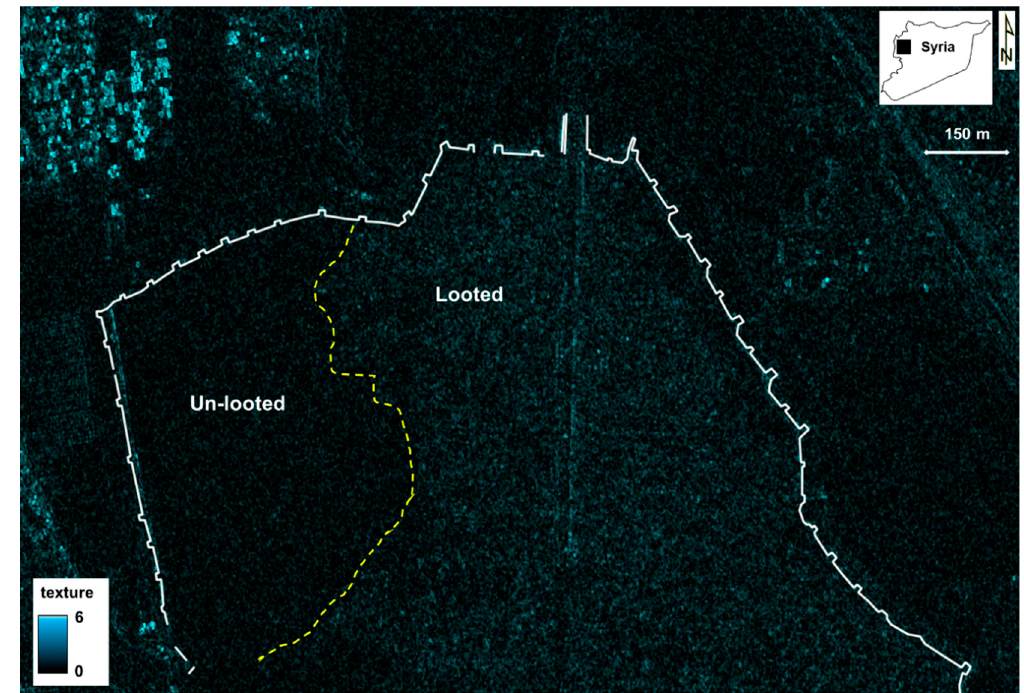
Figure 10. Texture map of the northern sector of the archaeological site of Apamea in Syria extracted from a COSMO-SkyMed Enhanced Spotlight image at 1-m ground resolution acquired on 16/07/2018 in ascending mode, using an incidence angle of 41°. Texture allows the looted areas to be separated from the un-looted fields in the privately-owned fields on the west (yellow dashed line). COSMO-SkyMed® Product ©ASI—Italian Space Agency—2018. All Rights Reserved.